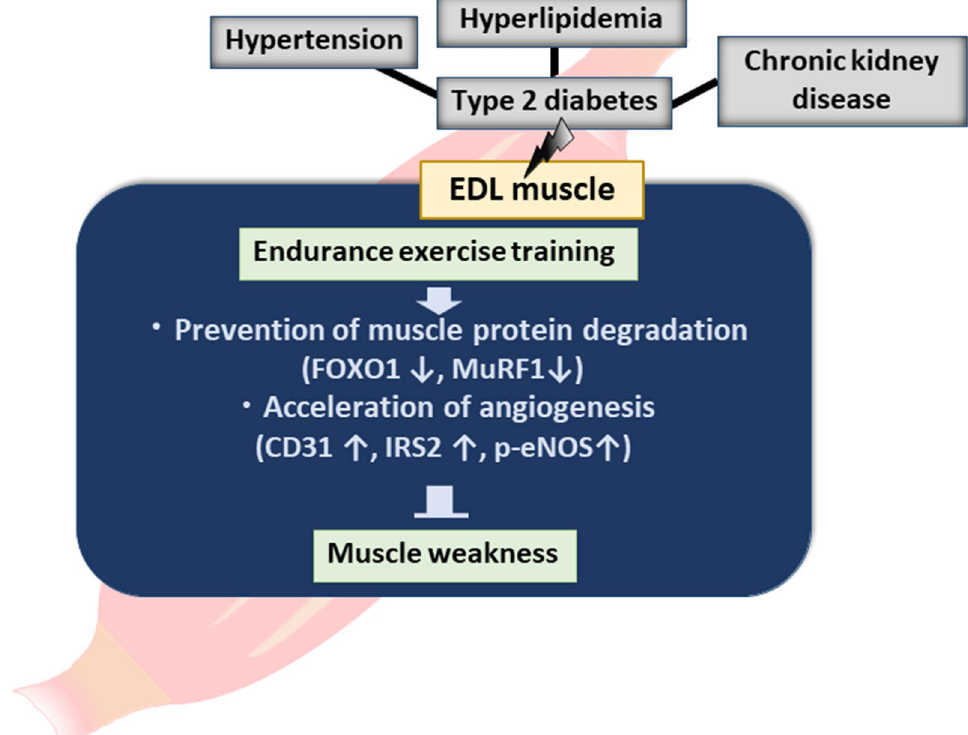
Fig. 10 Effective mechanisms of endurance exercise training on the extensor digitorum longus (EDL) muscle in rats with type 2 diabetes complicated by obesity, hypertension, and hyperlipidemia. The previous study indicated that endurance exercise training enhanced the muscle strength and cross‑sectional area of the type IIb muscle fibers of the EDL in type 2 diabetes with hypertension, hyperlipidemia, and chronic kidney disease (Additional file 1: Table S1–3, Fig. S1) [18]. As a mechanism, the present study revealed that the exercise training could improve muscle weakness by preventing muscle degradation and accelerating angiogenesis in the